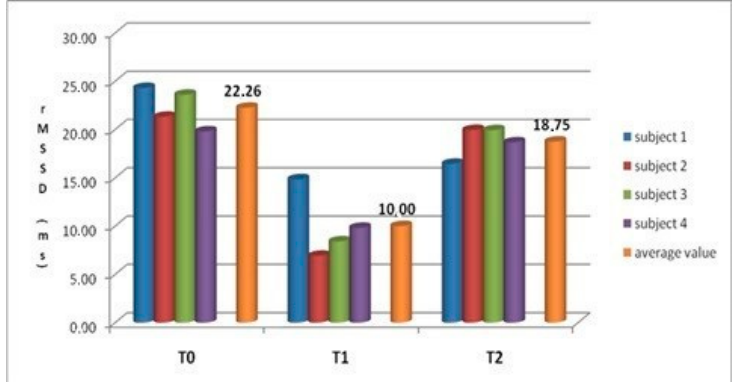
Figure 5. Individual and average values of rMSSD of Amiata donkeys EG 2 group at the times T 0 , T 1, and T 2 of the AAIs session.